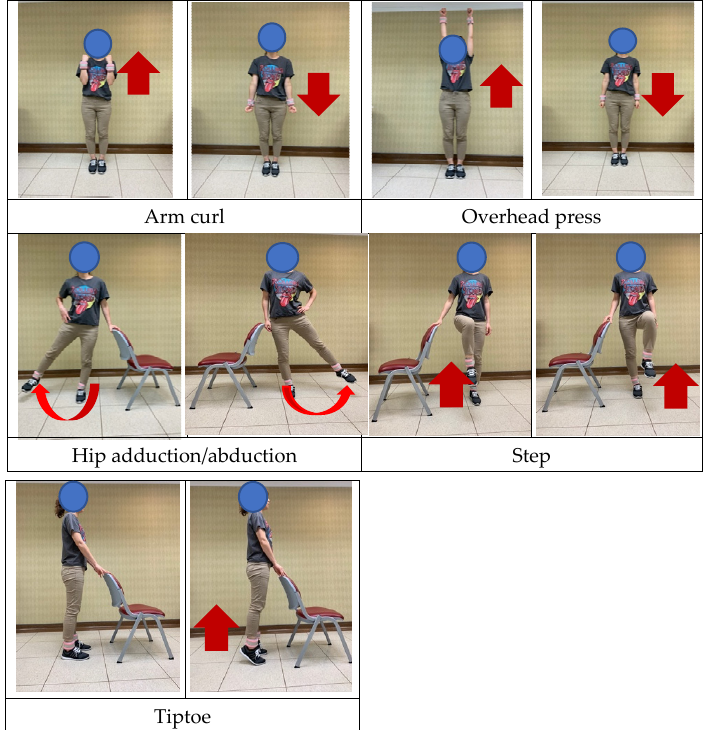
Figure 1. The five movements performed during resistance training.